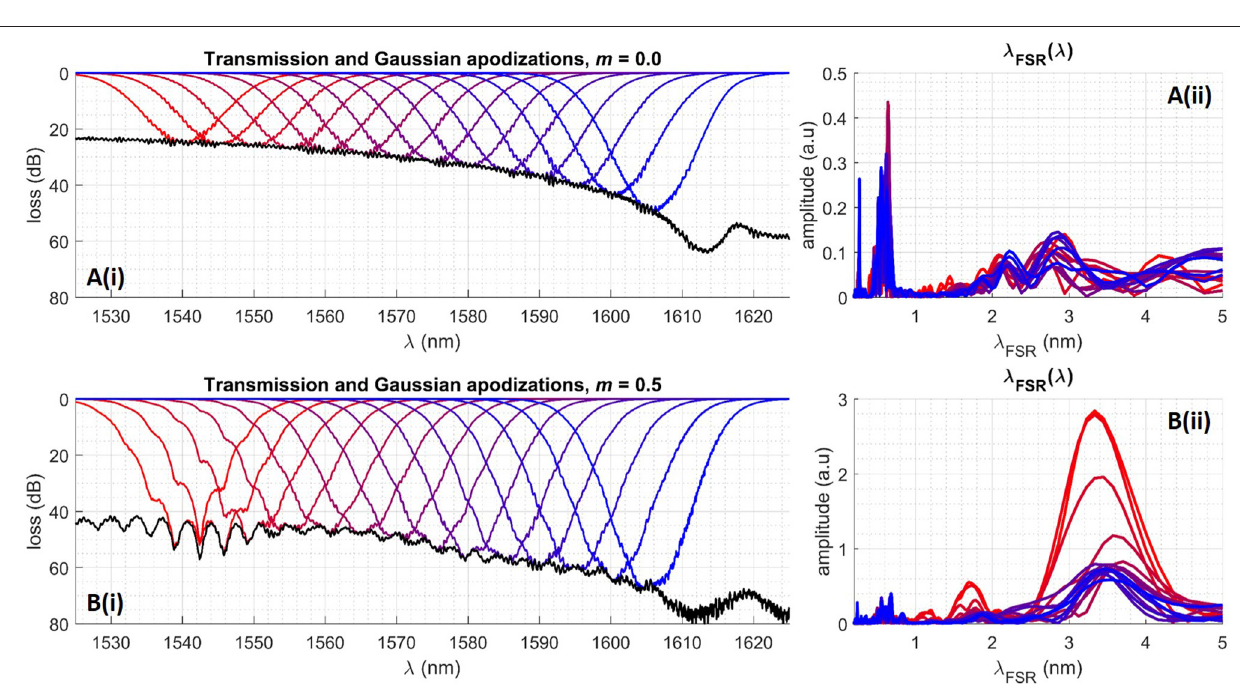
FIGURE 8 | Transmission spectrum (black line) for 250 µ m long fin-waveguide ( 3 = 350 nm, fill-factor = 0.5) with m = 0.0 (Ai) and m = 0.5 (Bi) , with overlaid Gaussian apodized spectra centered on λ = 1,540–1,605 nm (red to blue lines). (Aii,Bii) Show Fourier transforms of Gaussian apodization in (Ai,Bi) , which is the precise λ FSR of the transmission spectrum as a function of centered λ